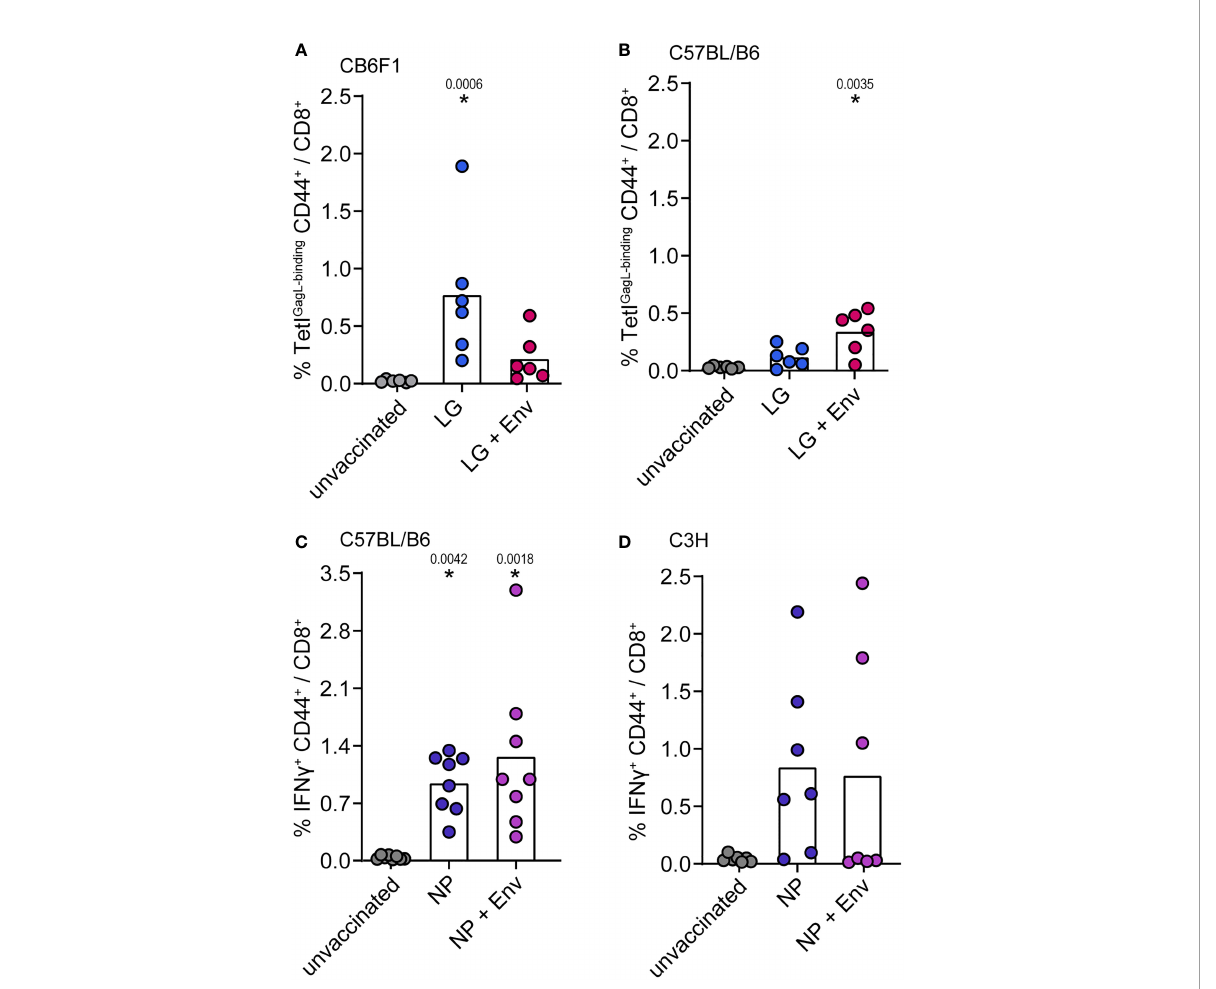
FIGURE 3 No suppression of in fl uenza nucleoprotein-speci fi c CD8 + T-cell responses. CB6F1 (A) and C57BL/B6 (B) mice were immunized once with 25 µg of the F-MuLV Leader-Gag encoding plasmid pCG.Leader-Gag alone (LG) or in combination with the F-MuLV Env SU+TM encoding plasmid pCG.env (LG + Env). (C) C57BL/6 mice and C3H mice (D) were immunized once with 25 µg of the nucleoprotein (NP) encoding plasmid pV.NP alone (NP) or in combination with pCG.env (NP + Env). Vaccinations were performed by intramuscular injection followed by in-vivo electroporation. Two weeks after immunization, mice were sacri fi ced and spleens were isolated, and the frequency of immunogen-speci fi c CD8 + T cells was determined by MHC-I tetramer staining (A, B) or by intracellular cytokine staining after in-vitro restimulation with the appropriate peptides (C, D) . Data from 8 (C) , 7 (D) , and 6 (A, B) mice per group were acquired in two independent experiments. Each dot indicates an individual mouse, and bars indicate mean values. Statistically signi fi cant differences compared with the unvaccinated group are indicated by * ( p < 0.05, Kruskal – Wallis one-way ANOVA on ranks, Dunn ’ s